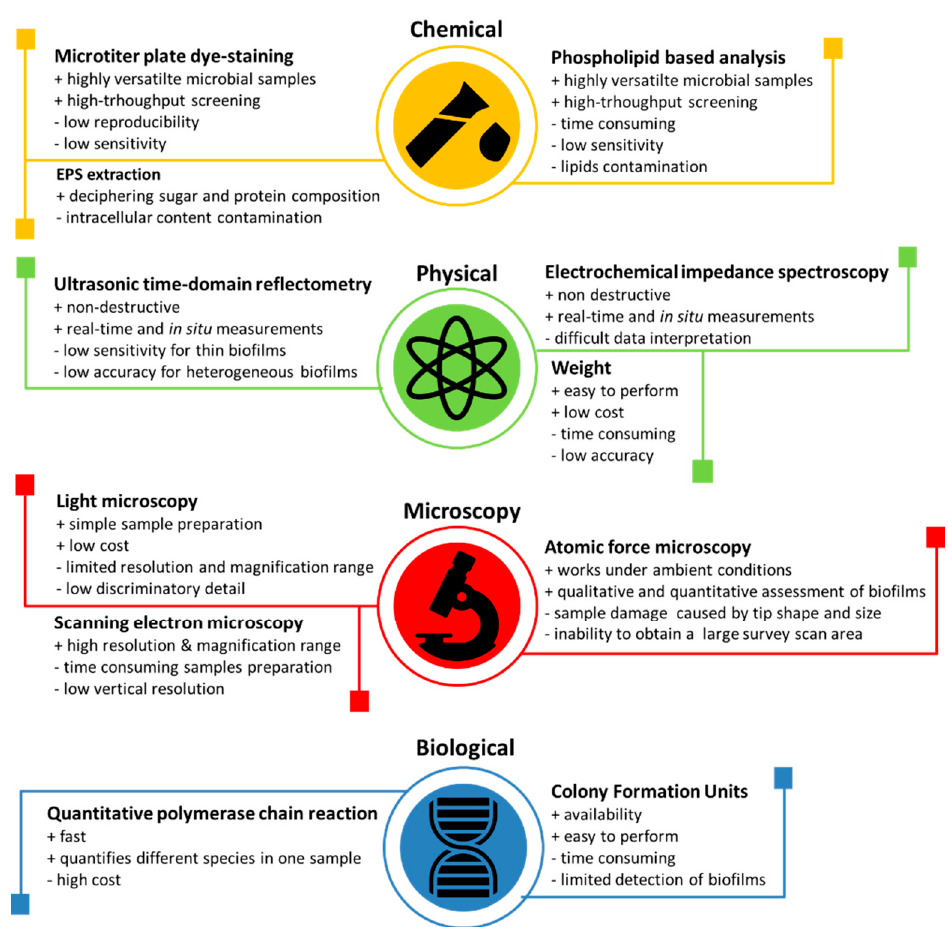
Figure 4. Biofilm detection and measuring techniques [55–58].